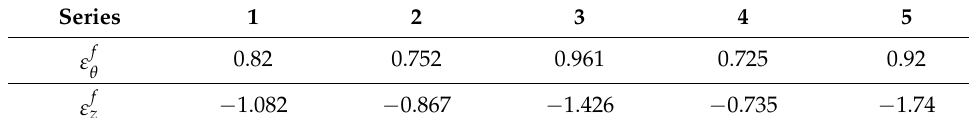
Figure 3. Typical geometric changes after each increment of the die’s displacement (Series 5).